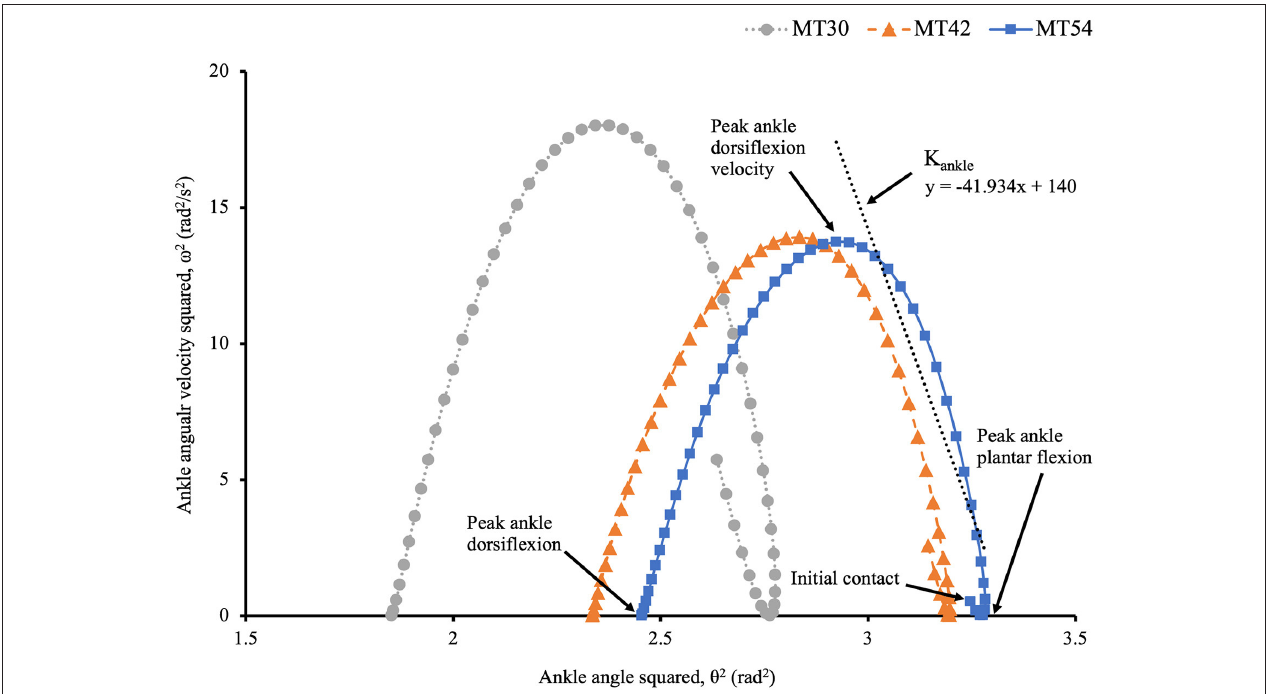
FIGURE 3 | The relationship between ω 2 and θ 2 of ankle joint on a typical subject trial between shoe conditions during the first half of stance. 1 (cid:0) ω 2 (cid:1) /1 (cid:0) θ 2 (cid:1) for ankle joint stiffness calculation was determined as the slope of the regression line shown above (i.e., the coefficient of the regression equation) throughout 20–80% of the data points (the most linear portion) of the impact